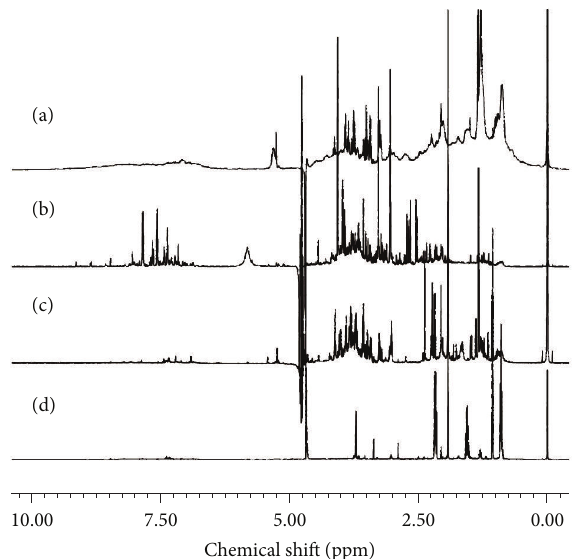
Figure 2: Examples of NMR profiles of (a) serum, (b) urine, (c) saliva, and (d) faecal